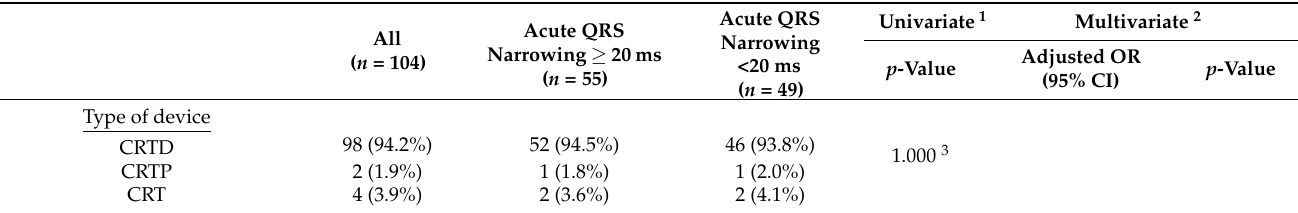
Table 1. Patients’ characteristics and clinical history prior to CRT implantation according to post-CRT acute QRS narrowing ≥ 20 ms or <20